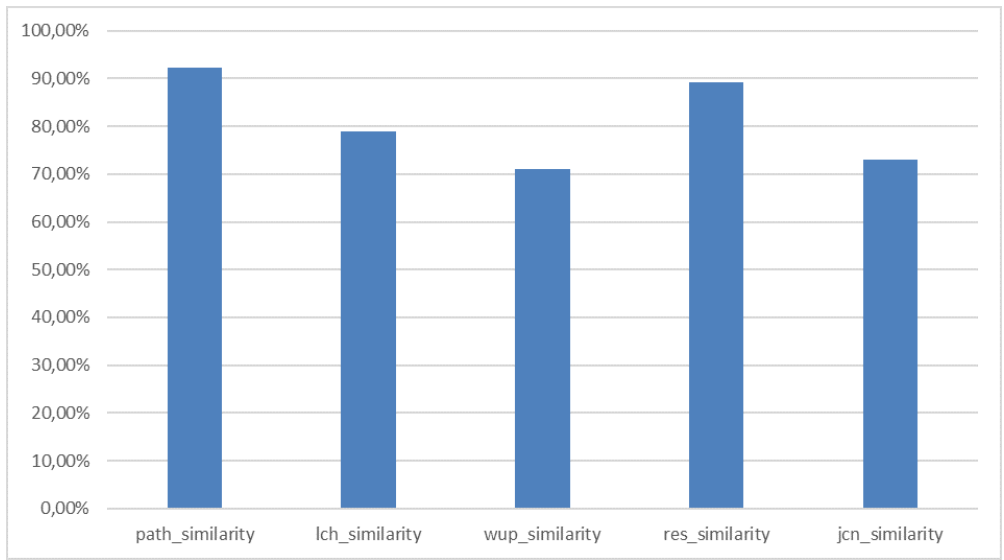
Figure 12. MAP@10 for Textual Semantic Similarity